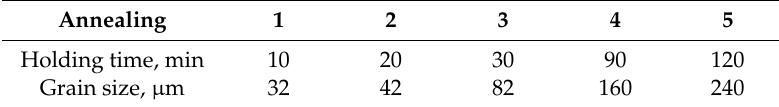
Table 2. Annealing process of copper wire for di ff erent holding time under 700 ◦